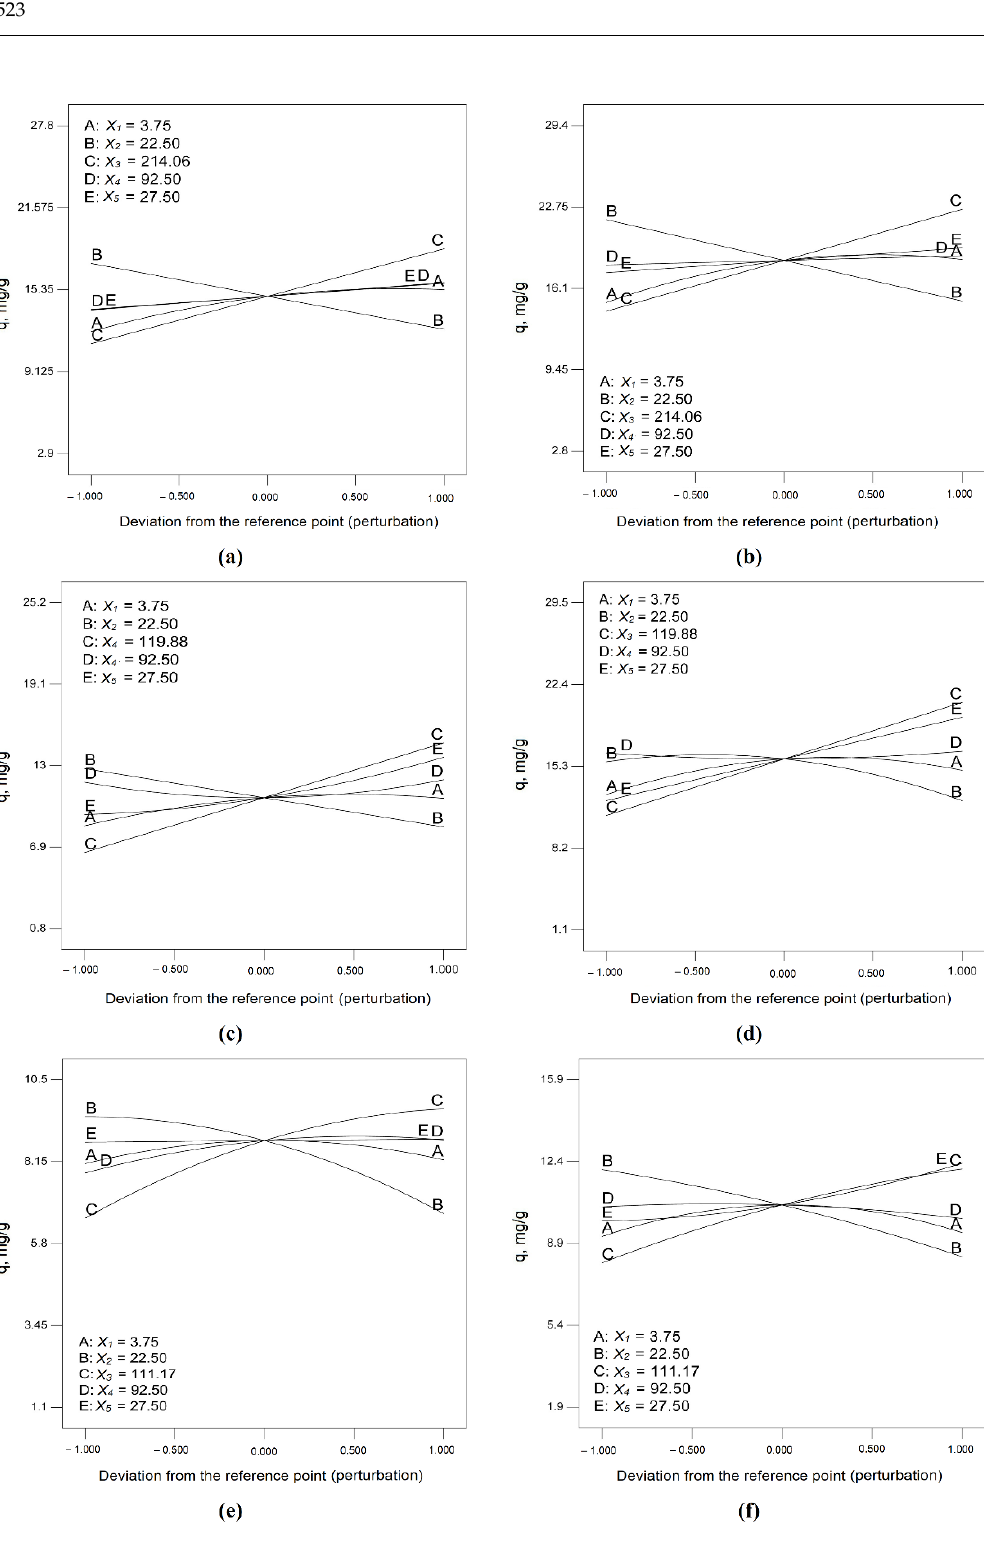
Figure 12. Perturbation diagrams resulting from the sensitivity analysis for the mathematical models developed for biosorption capacity of soybean biomass and soybean waste biomass (the meaning of the notations ( a – f ) is the same as those from Figure 9).